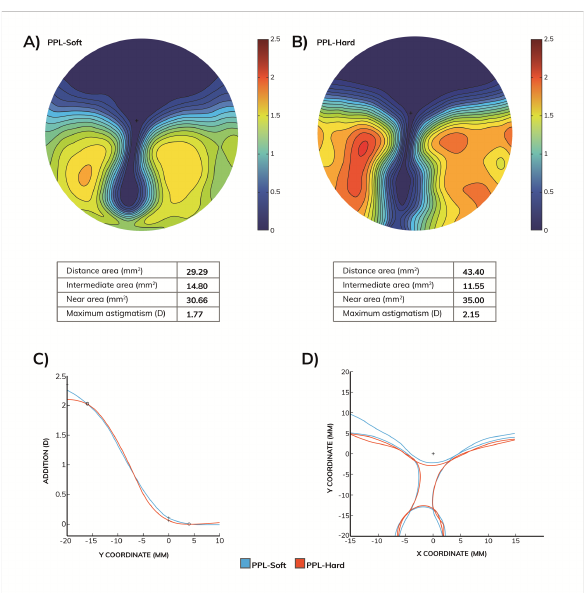
Figure 1. Power distribution maps of the PPL designs tested in this study. A) Cylinder power distribution maps and visual area according to Sheedy criteria of the PPL-soft lens. B) Cylinder power distribution maps and visual area according to Sheedy criteria of the PPL-hard lens. C) Progression profile.